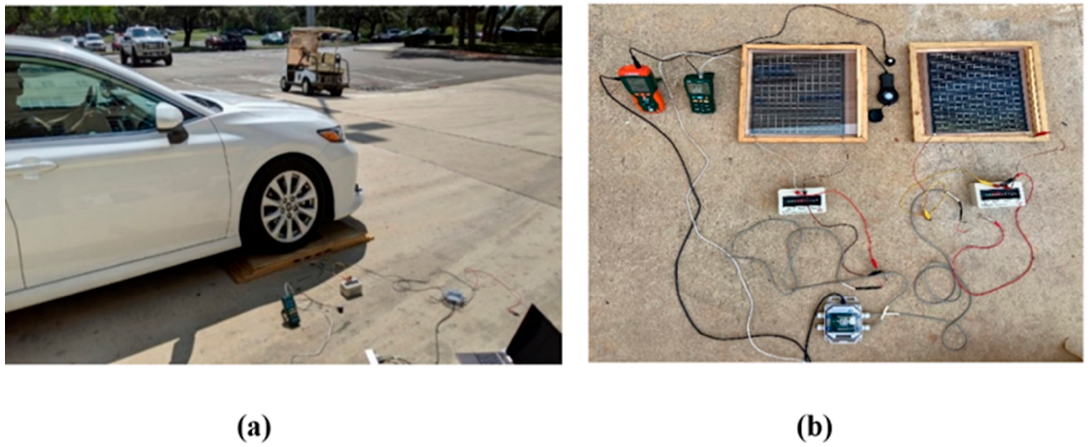
Figure 5. ( a ) Test of solar panel under the wheel load, and ( b ) experimental setup for performance evaluation in outdoor conditions.